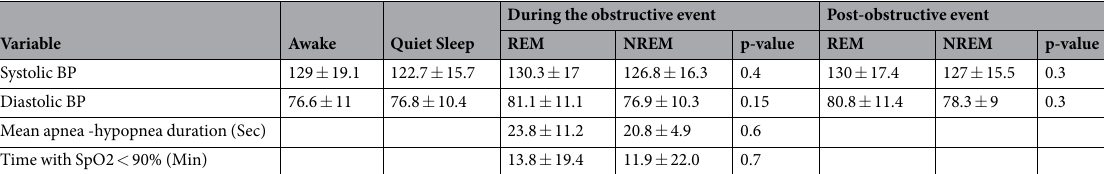
Table 3. Comparison of blood pressure during obstructive and post-obstructive respiratory events between REM and NREM